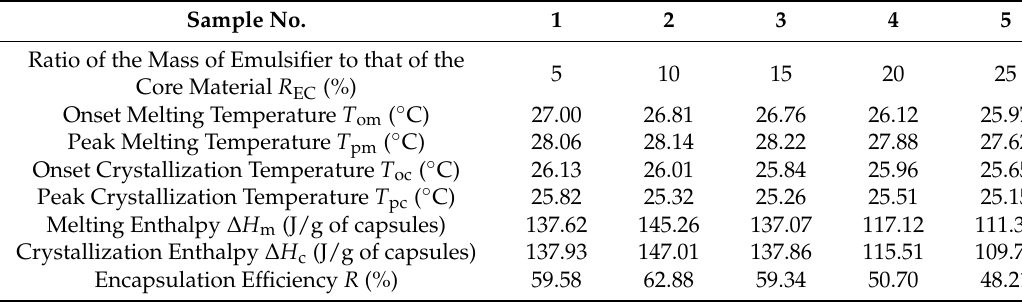
Table 6. Thermal properties of M-NEPCMs prepared by using different amounts of emulsifier. Sample No. Ratio of the Mass of Emulsifier to that of the